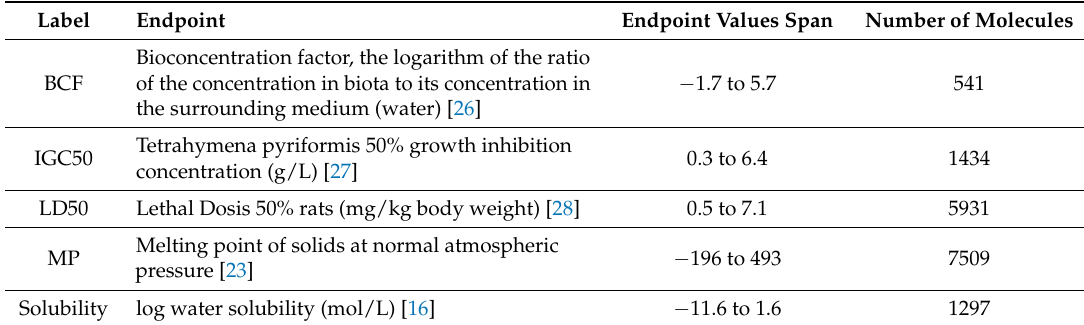
Table 5. The datasets used for quantitative structure activity relationship (QSAR)